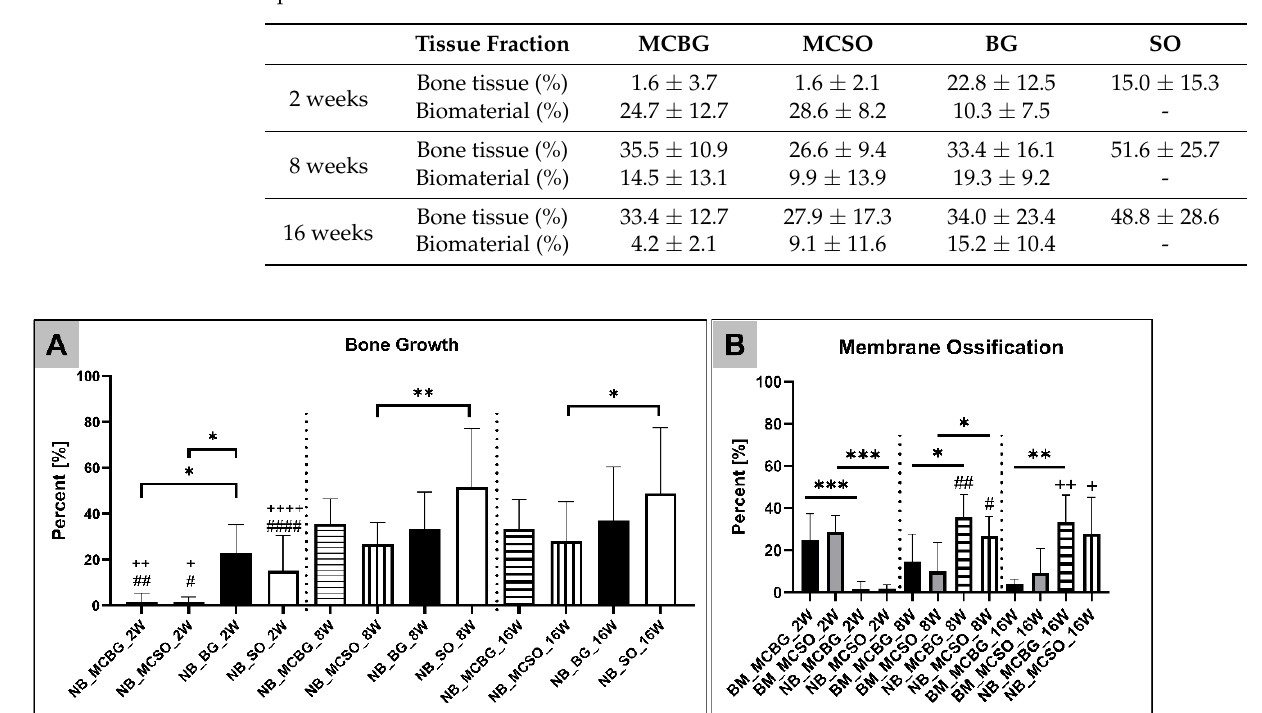
Figure 3. ( A ) Results of bone regeneration at 2, 8, and 16 weeks post implantationem. ( B ) Results of the membrane ossification measurements in comparison to membrane resorption within both membrane compartments. Intraindividual significances: * p < 0.05, ** p < 0.01, *** p < 0.001; interindividual significances: #/+ p < 0.05, ##/++ p < 0.01, and ####/++++ p < 0.0001. For ( A , B ), # indicates significant differences between the 2- and 8-week datasets and + indicates significant differences between the 2- to 16-week datasets. NB = newly formed bone; BM = biomaterial; MCBG: membrane compartment above bone graft-filled defects; MCSO: membrane compartment above sham operation; BG: bone graft- fi lled defect; and SO: sham operation bone defect.